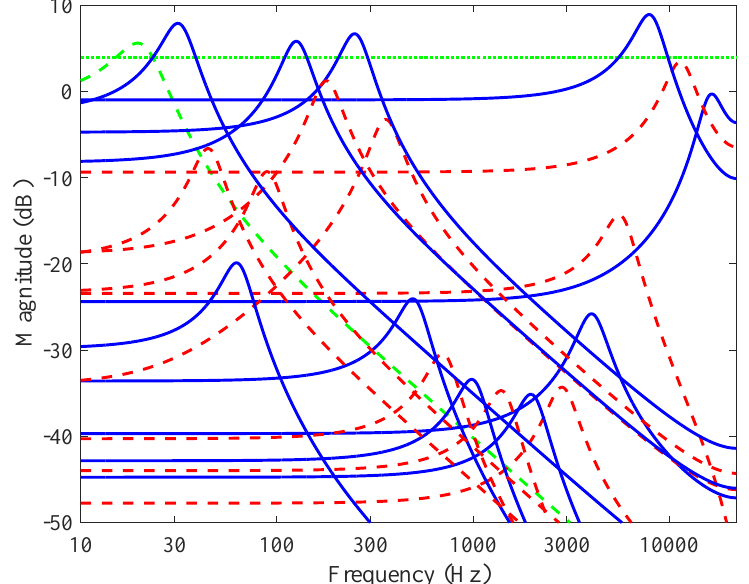
Figure 12. Parallel subfilter responses forming the magnitude response of Figure 11: filters at command bands (solid blue lines), slave filters between bands (red dashed lines), extra filter at 20Hz (green dashed line), and the direct path gain (green dotted